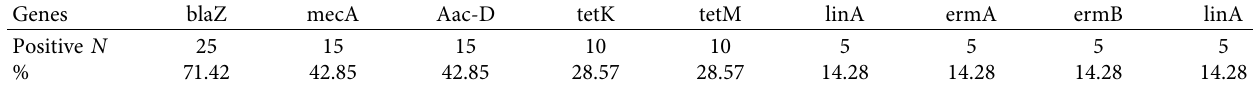
Table 5: Prevalence of antibiotic resistance genes in S. aureus strains isolated from row cow milk.